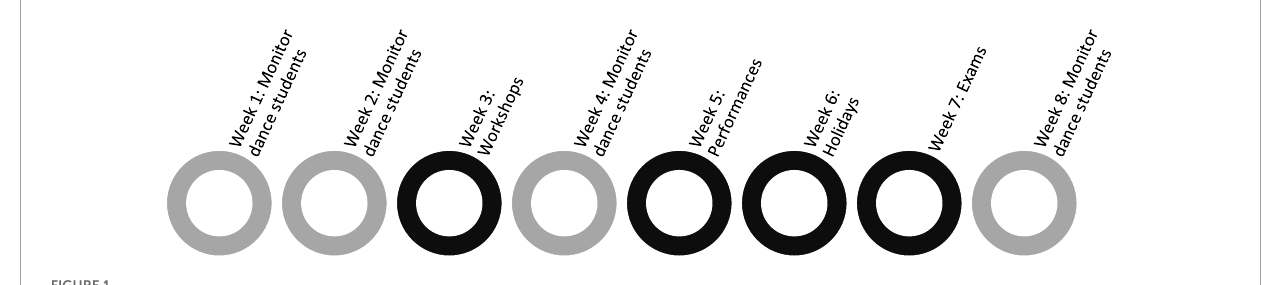
FIGURE1 Time line of monitoring the dance students. The gray circles represent the data collection